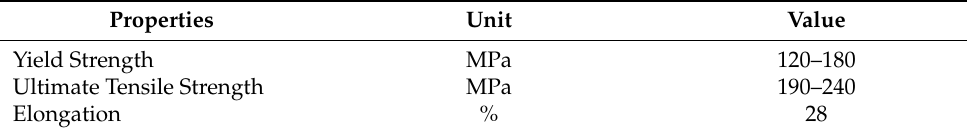
Figure 3. Normal LITECOR ® layers. Table 1. LITECOR ® mechanical properties [26]. Table 1. LITECOR ® mechanical properties